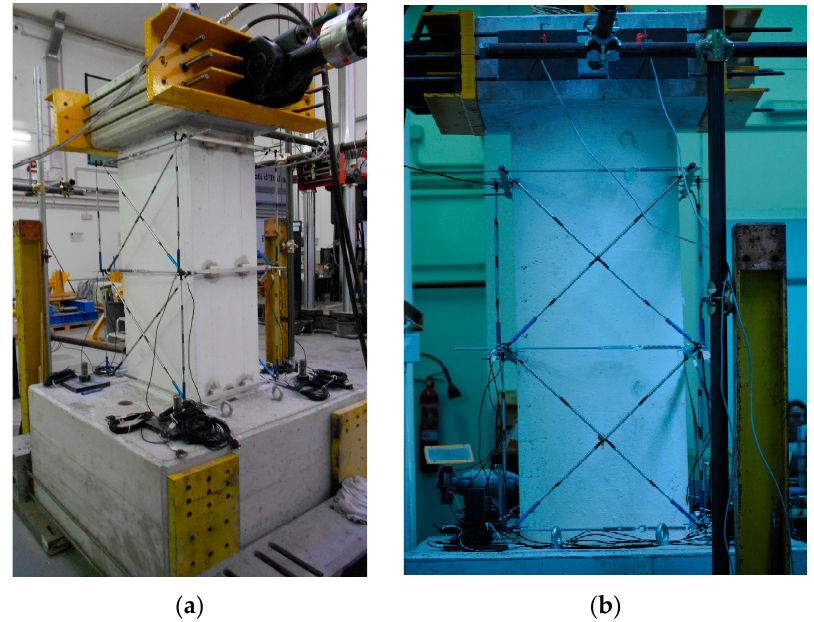
Figure 10. Monitoring system for cyclic test: ( a ) rectangular pier and ( b ) circular pier.